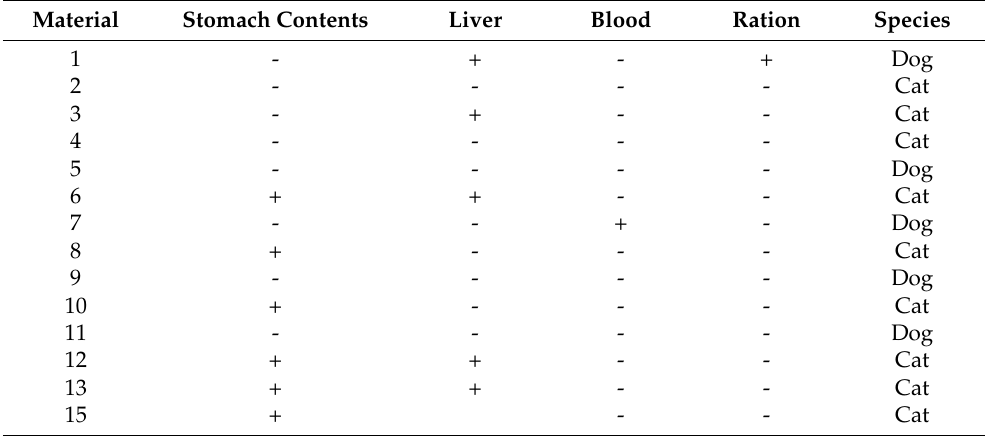
Table 20. Cases of suspected poisoning by the pesticide aldicarb in animals whose tissue and feed samples were sent to the Laboratory of Toxicological Diagnosis (LADTOX) from 2014 to June